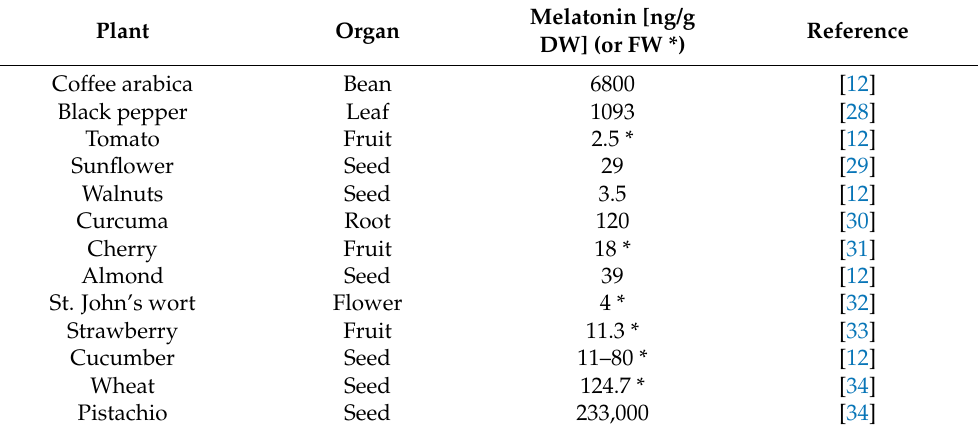
Table 1. Phytomelatonin content in some